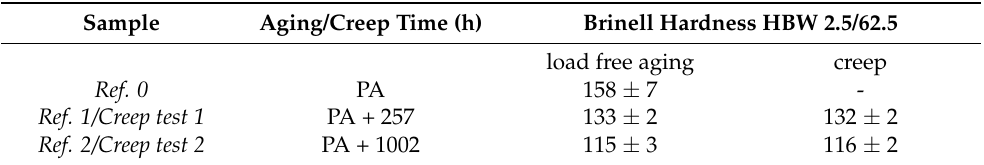
Table 2. Brinell hardness after aging without and with stress.